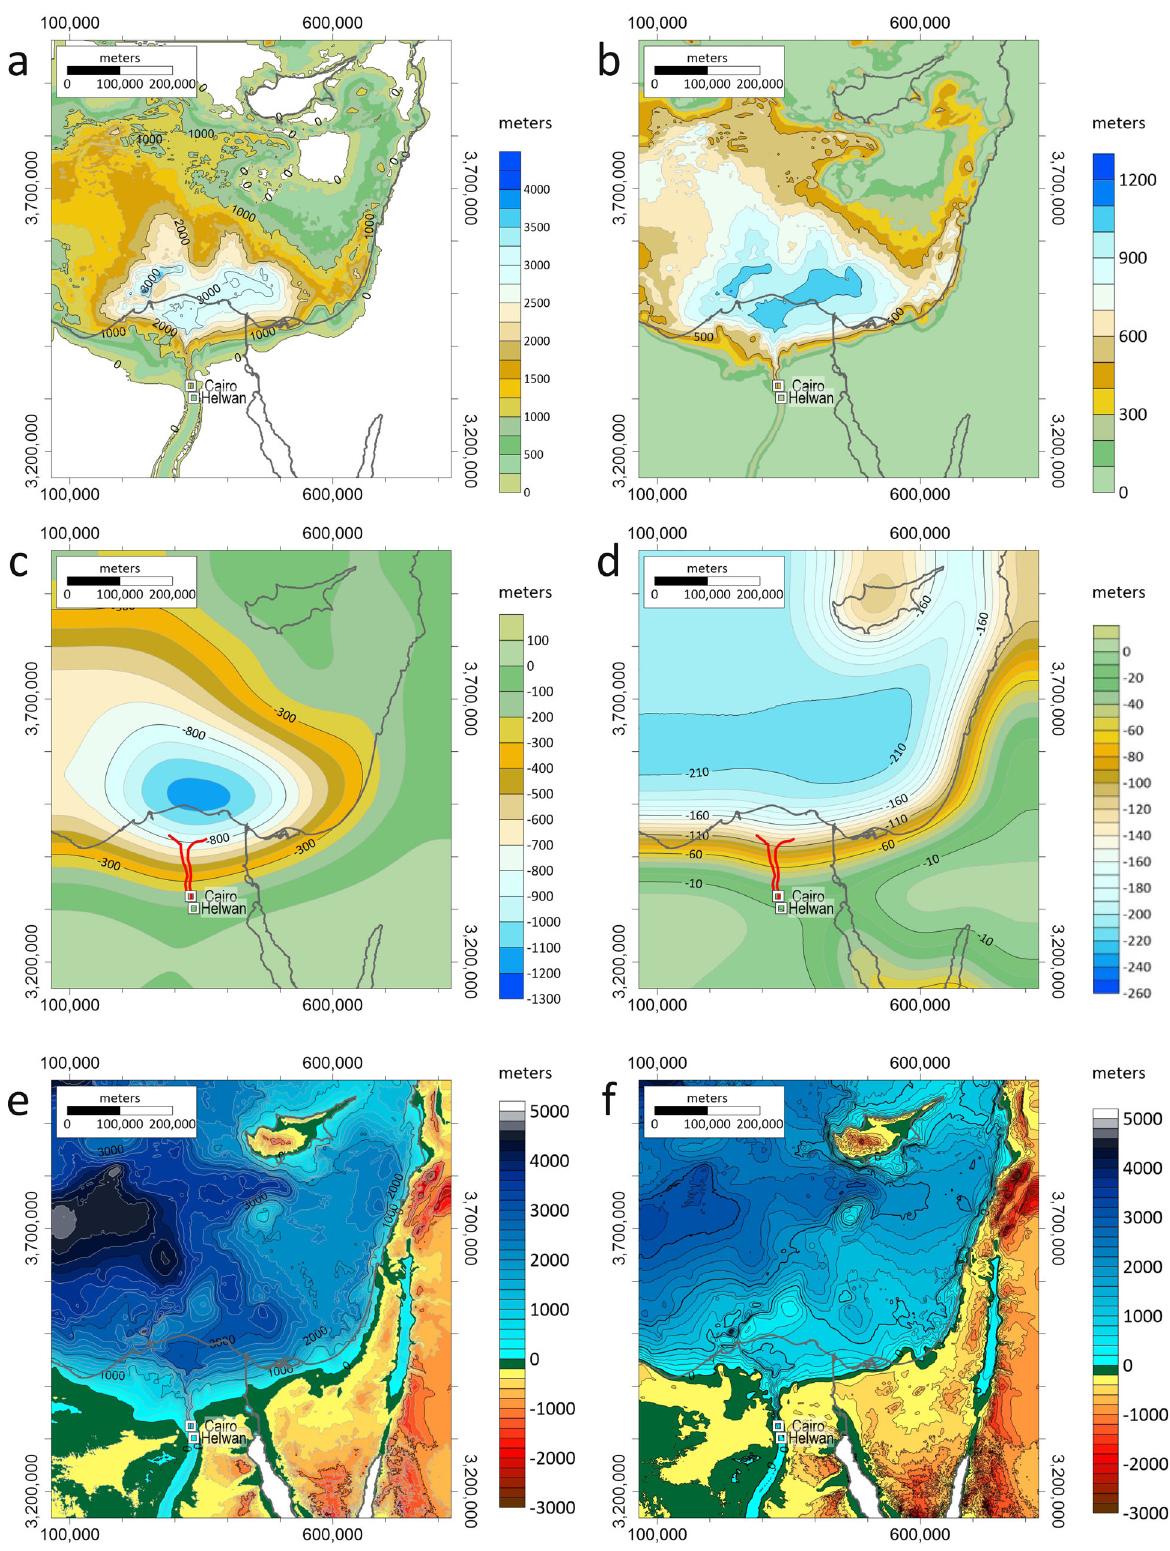
Fig. 2 Maps illustrating how the Messinian erosional surface (MES ~ base Pliocene) is restored to its original vertical position. a Thickness of rocks covering the base Pliocene surface. b Calculated subsidence due to compaction of pre-Pliocene sediments assuming shale lithology (for other lithologies see Supplementary Fig. S1). c Calculated fl exural de fl ection due to unloading of post-Messinian rocks, using elastic thickness, Te = 30 km (for other Te values see Supplementary Fig. S2). d Calculated fl exural de fl ection due to unloading of a 650-m-thick water layer (Te = 30 km, for other values of water thickness and Te see Supplementary Fig. S3). e Observed base Pliocene structural map 50 (modi fi ed). f Restored base Pliocene surface after correcting for compaction (shale) and de fl ection (Te = 30 km) due to sediment unloading. No correction for water unloading has been applied here.